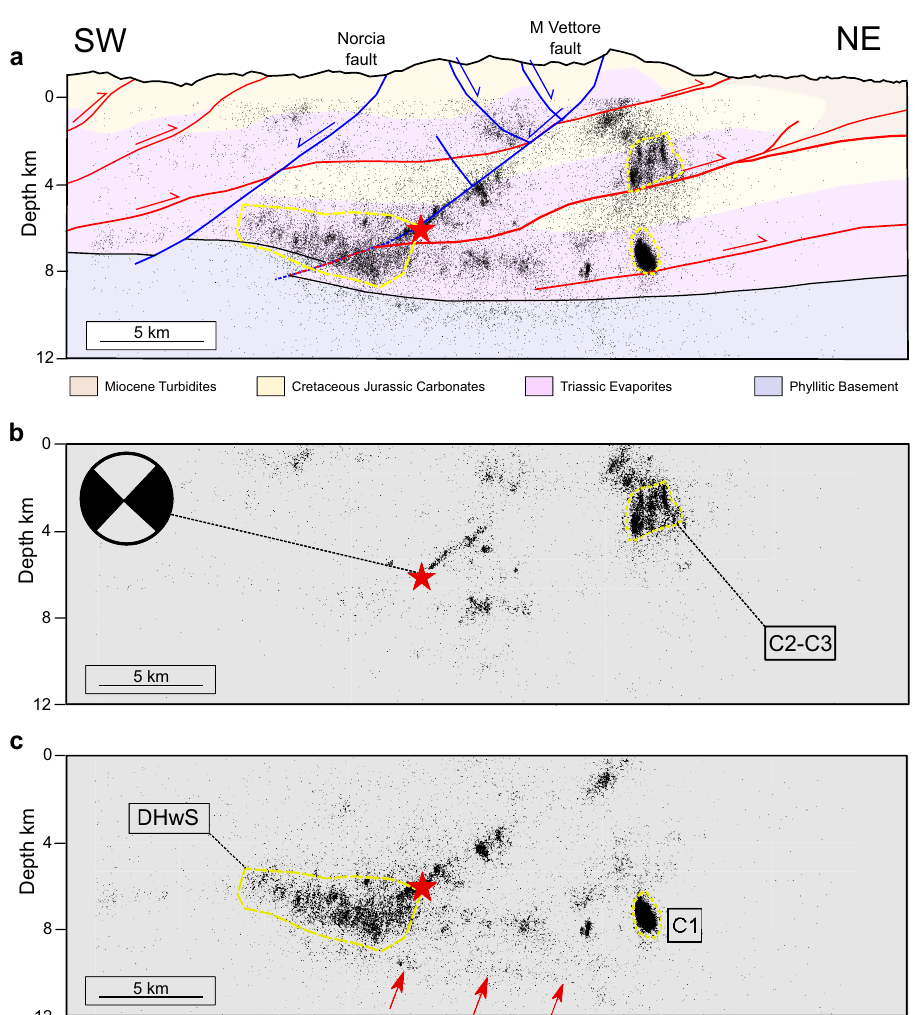
Fig. 2 | Seismicity vs. geology. a Cross section (trace in Fig. 1) integrating surface and subsurface geology (details in Supplementary Note 1 and Supplementary Figs.1,2)withtheearthquakedistribution(entirecataloguefrom08/15/2016to08/ 15/2017). b seismicity from Amatrice (8/24/2016) to Visso (10/26/2016) mainshock and c afterNorcia(10/30/2016)mainshock.Cross-sectionsareperpendiculartothe strike (155°, from the moment tensor solution) of the Norcia mainshock (red star